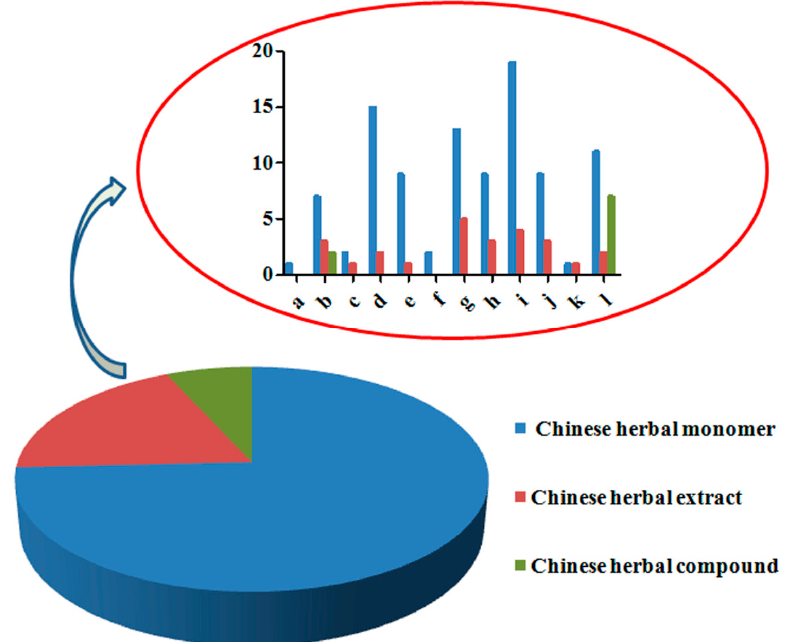
Figure 5. The applications of related pharmaceutical technologies for Chinese herbal monomers, extracts and compound. (a: bioadhesive polymers; b: mircoemulsion; c: self-microemulsion; d: nanosuspensions; e: polymer β -Cyclodextrin inclusion; f: polymeric micelles; g: liposomes; h: phospholipid complex; i: solid lipid nanoparticles; j: solid dispersion; k: micronization; l: absorption enhancer).